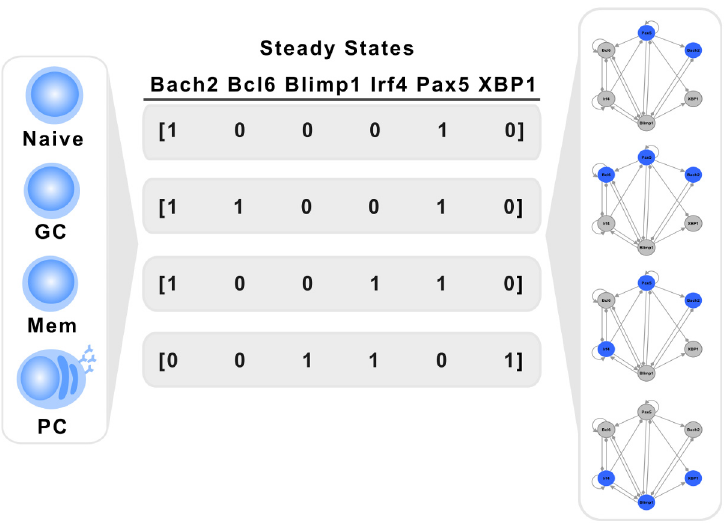
Fig 3. Attractors and cell types The stationary states of the regulatory network correspond to multiple activation patterns that characterize different cell types.